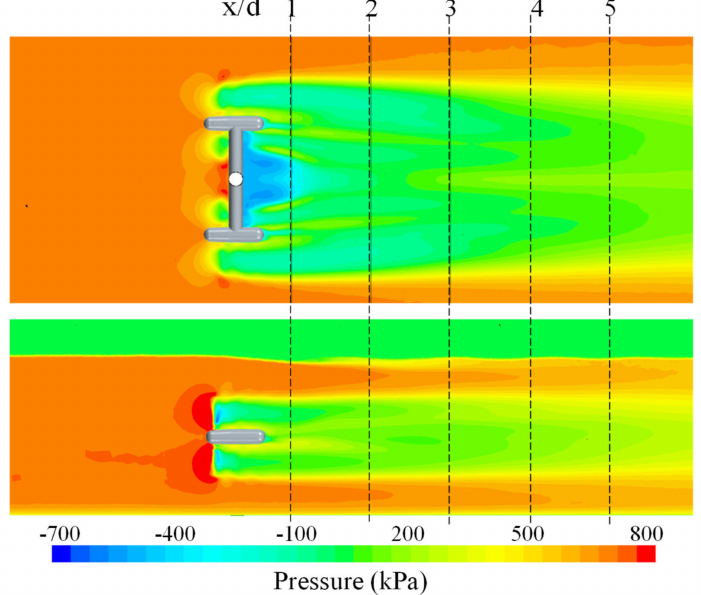
Figure 12. Pressure measurements over the horizontal and vertical planes (at the turbine hub height